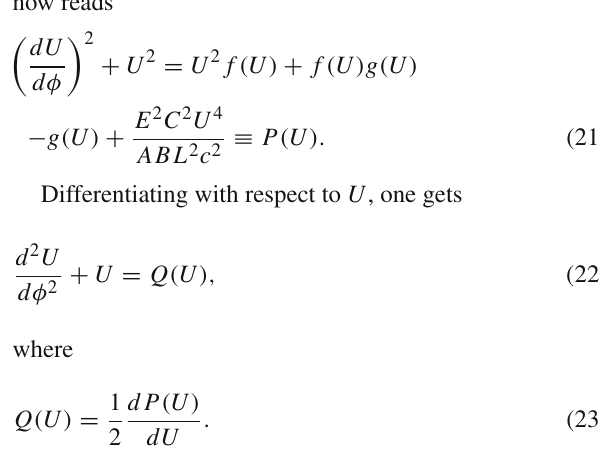
Table 2 Angle of deflection for different parametric